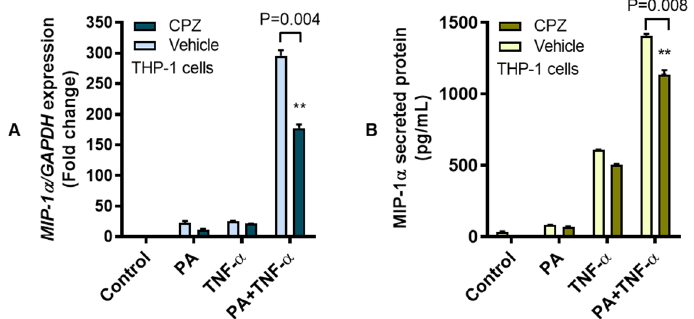
Figure 3. Co-induction of MIP-1α by palmitate and TNF-α involves clathrin-mediated endocytosis. To determine whether the cooperative induction of MIP-1α involved clathrin-mediated endocytosis (CME), THP-1 monocytic cells were treated with the CME inhibitor chlorpromazine CPZ (20 μM for 1 h) before stimulation with palmitate (200 μM) and/or TNF-α (10 ng/mL), while control wells were treated with 1%BSA. Cells were incubated at 37 °C for 24 h and cells were collected for total RNA extraction for measuring MIP-1α gene expression and supernatants were collected for measuring MIP-1α secreted protein as described in the Materials and Methods section. The representative data (mean ± SEM) obtained from three independent determinations with similar results show that CPZ-treated cells displayed the reduced expression of ( A ) MIP-1α mRNA ( P = 0.004) and ( B ) MIP-1α secreted protein ( P = 0.008) compared to controls treated with the vehicle only before co-stimulation with palmitate and TNF-α. ** denotes a P -value < 0.01.